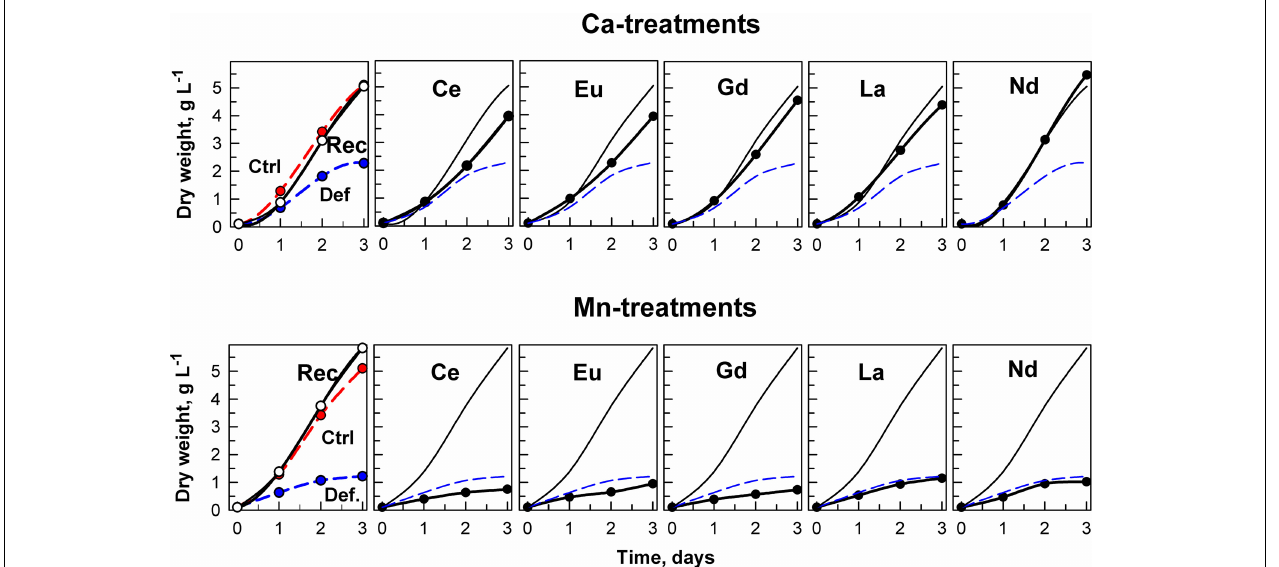
FIGURE 2 | Changes in dry weight in cultures of the alga Desmodesmus quadricauda grown either in complete mineral medium (Ctrl, red symbols, dashed curve) or in calcium- (upper raw of panels) or manganese-deficient mineral medium (bottom raw of panels) (Def., blue symbols, dashed curves). To calcium and manganese deficient cultures